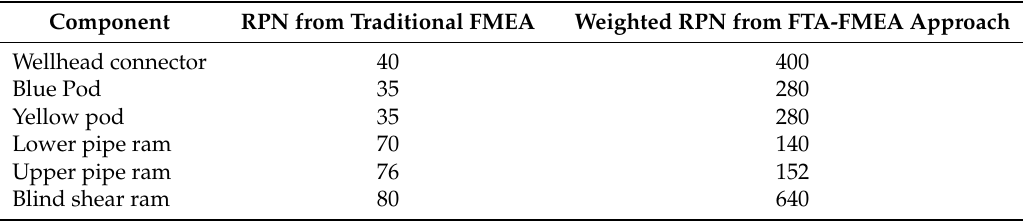
Table 7. A comparison between the results obtained from the traditional FMEA technique with those obtained by the proposed